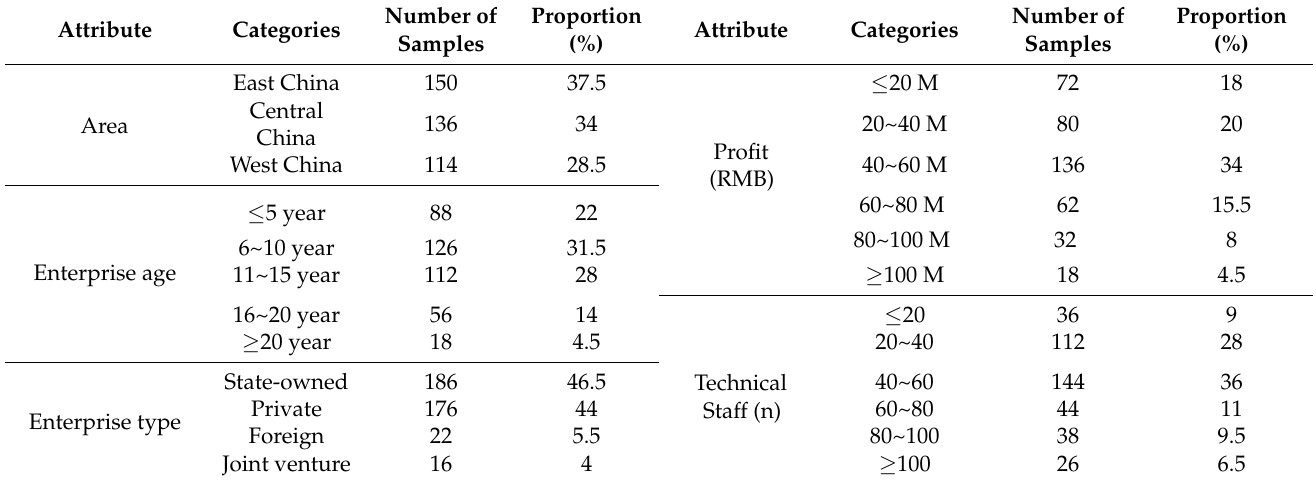
Table 1. Sample characteristics.